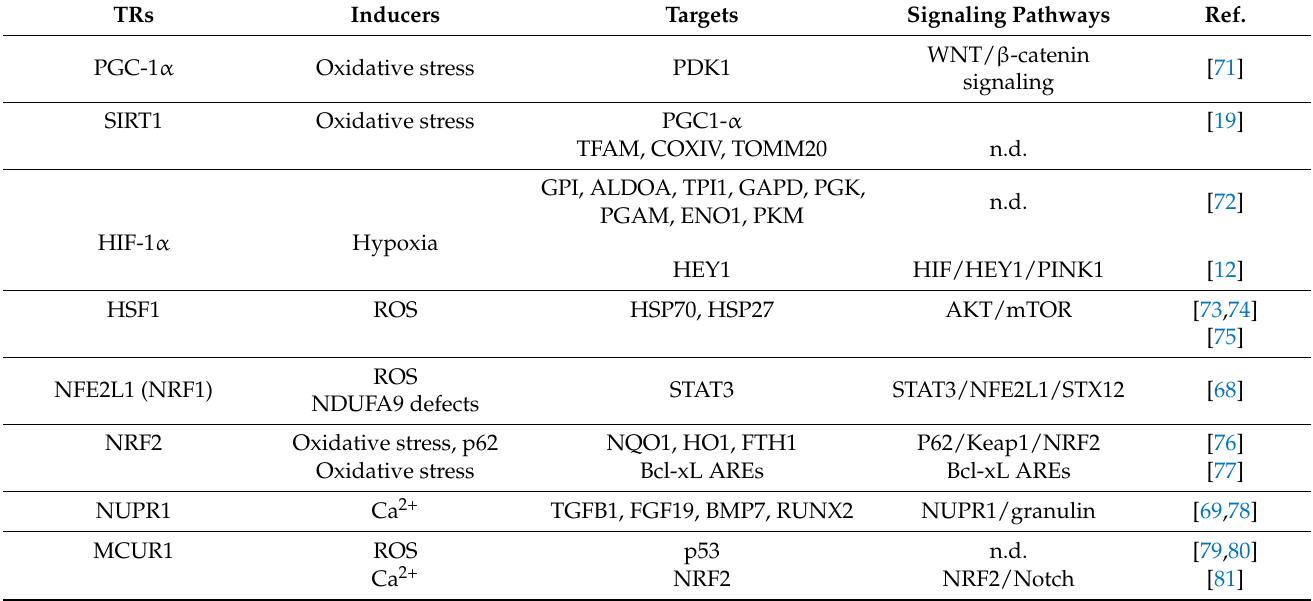
Table 1. Transcriptional regulators (TRs) induced by mitochondrial retrograde signaling in HCC. TRs Inducers Targets Signaling Pathways